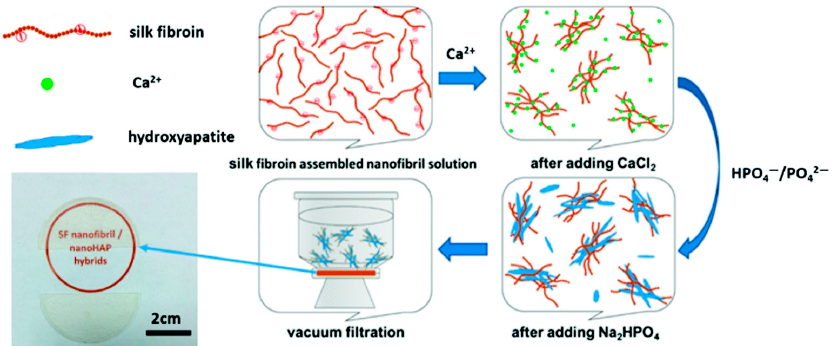
Figure 22. Schematic representation of the procedure followed to prepare silk fibroin nanofibril/nanoHAP films and the resultant photograph. Image adapted with permission from reference [83]. Copyright 2016 Royal Society of Chemistry.